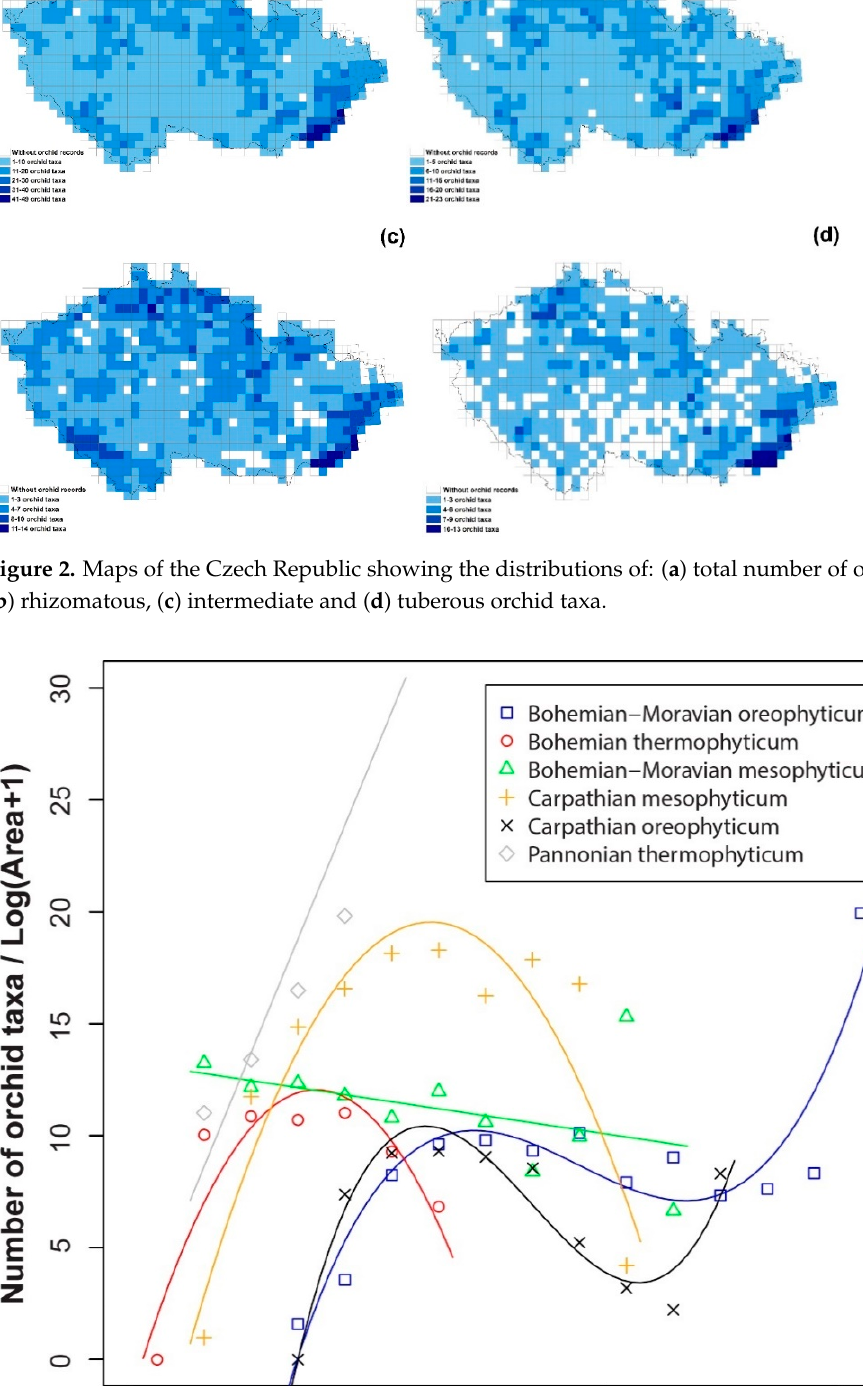
Figure 2. Maps of the Czech Republic showing the distributions of: ( a ) total number of orchid taxa, ( b ) rhizomatous, ( c ) intermediate and ( d ) tuberous orchid taxa.